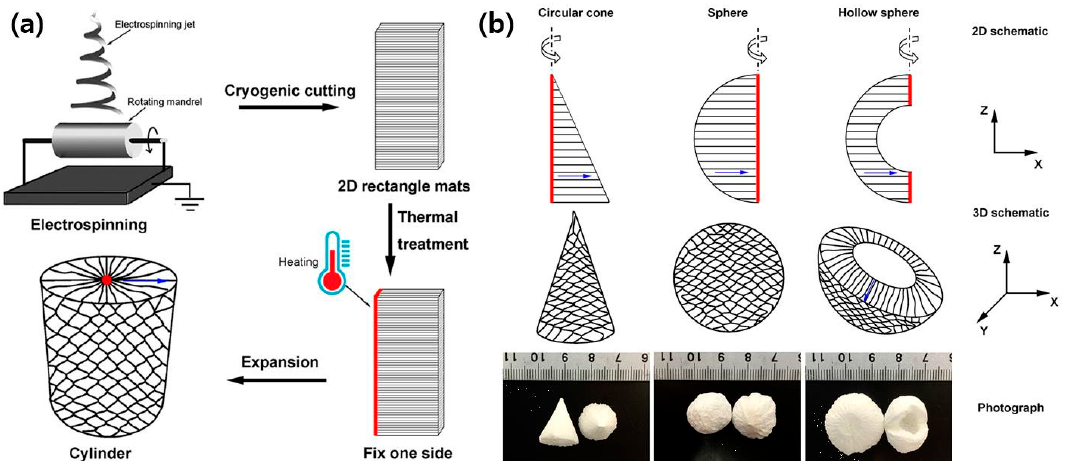
Figure 11. ( a ) Representative process for transformation of 2D nanofiber mats into 3D object, and ( b ) design and realization of the desired shapes. [Adapted with permission from 98. Copyright (2019) American Chemical Society].